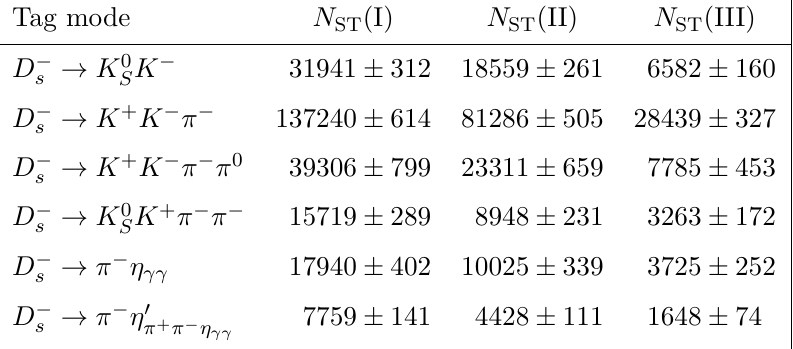
Table 10 . The ST yields for the data samples collected at and (III) 4.226 GeV. The uncertainties are statistical.